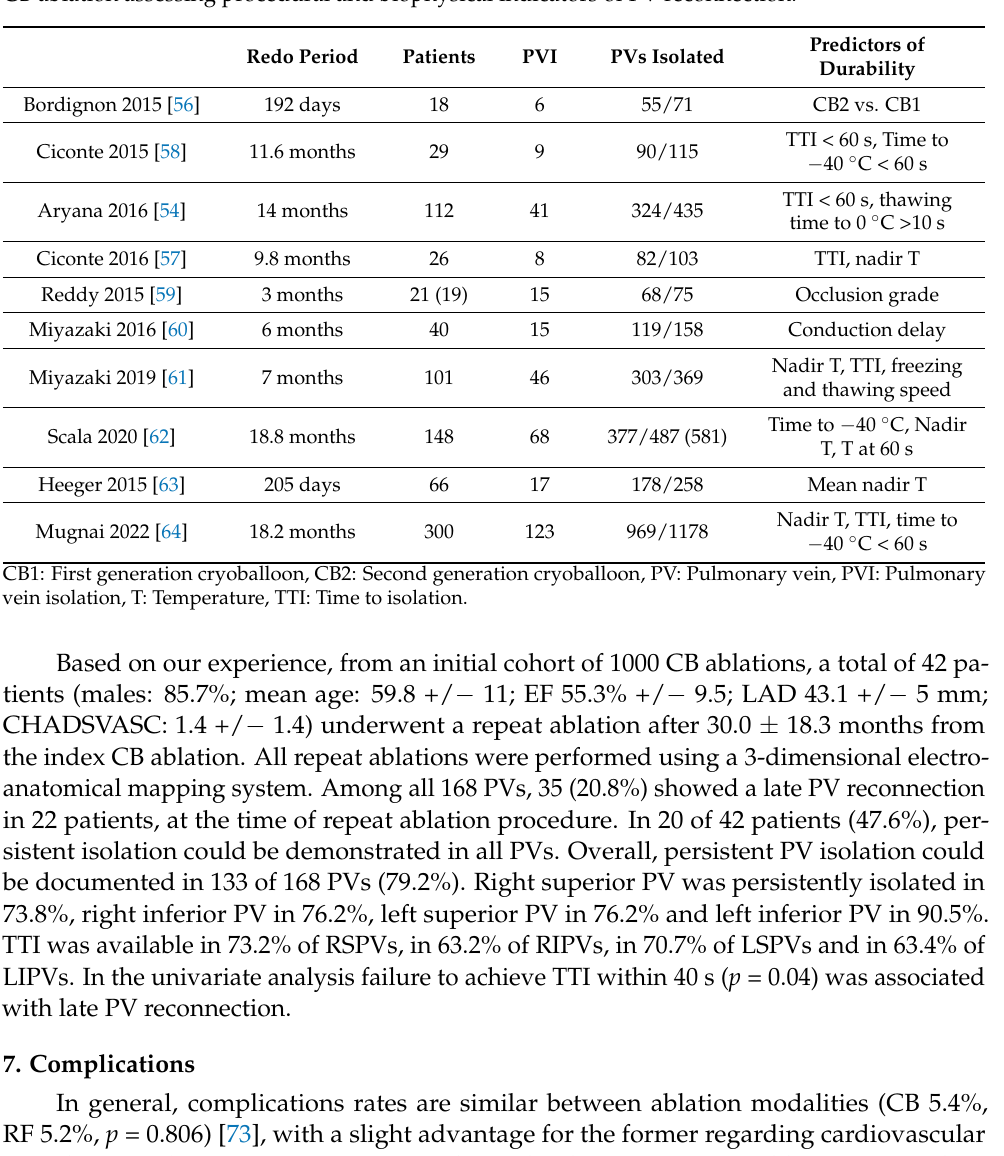
Table 2. Studies that have analyzed data from redo electroanatomical mapping procedures post index CB ablation assessing procedural and biophysical indicators of PV